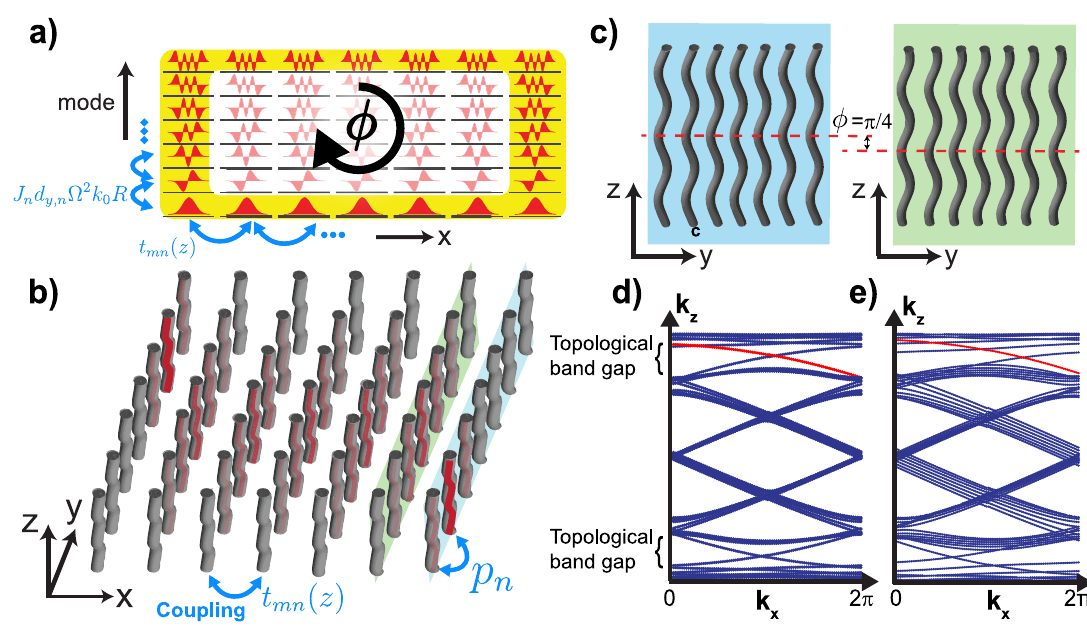
Figure4: Thetwo-dimensional(2D)syntheticspacephotonictopologicalinsulatormadeofanarrayofjudiciouslymodulatedwaveguide[46]. (a, b) The synthetic space lattice (a) corresponding to the two-dimensional lattice of waveguides in real-space (b). The basic building block is a one- dimensional (1D) array of N evanescently coupled waveguides, with the spacing between waveguides judiciously engineered such that it yields N Bloch modes with equally spaced propagation constants [49]. To facilitate transport in the model dimension, the modes are coupled by spatially oscillatingthewaveguidesinthepropagationdirection,creatingaladderofcoupledmodes.Arranging M such1Darraysnexttooneanother,withthe oscillationsphase-shiftedfromoneanother,resultsinthe2Dtopologicalinsulatorinsyntheticspace.Theedgestateofthesyntheticspace(yellowin (a))residesinthebulkofthewaveguidearrayof(redin(b)).(c)Thephaseshiftbetweeneachtwoadjacentcolumnsofthewaveguidearrayof(b).(d) The Floquet band structure of the lattice with the edge state marked by the red line. (e) The Floquet band structure under random disorder in the couplingbetweenwaveguides.Disordermostlycausesshiftsandslightdeformationsinthedispersioncurveoftheedgestatebutdoesnotclosethe topological gap, highlighting the immunity of the topological edge state to